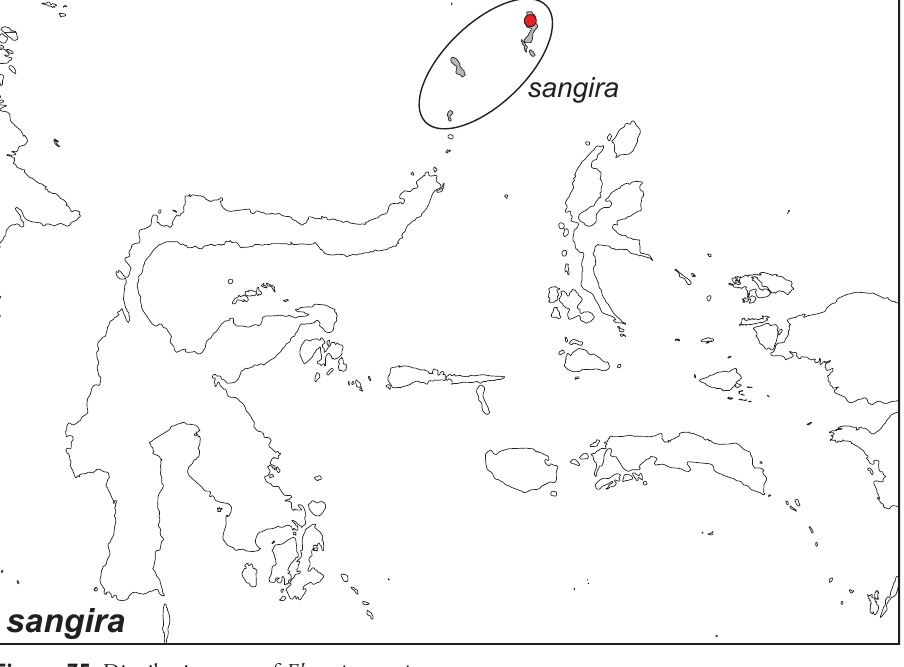
Figure 75. Distribution map of Elymnias sangira .